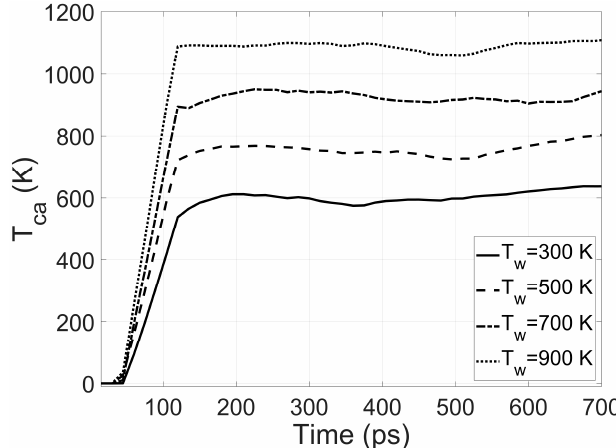
Figure6. Temperatureatthecuttingarea( T ca )vs. timeforvariousvaluesoftheworkpiecetemperature( T w ). Figure 6. Temperature at the cutting area ( T ca ) vs. time for various values of the workpiece temperature ( T w ).